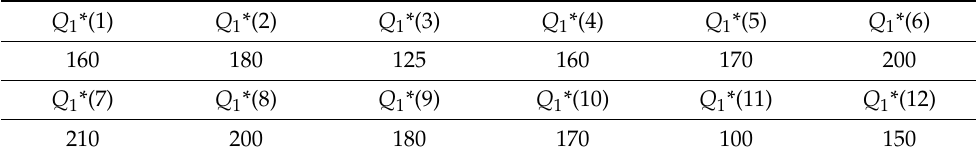
Table 9. Economical delivery plan for warehouse 1 ( τ * = 1).